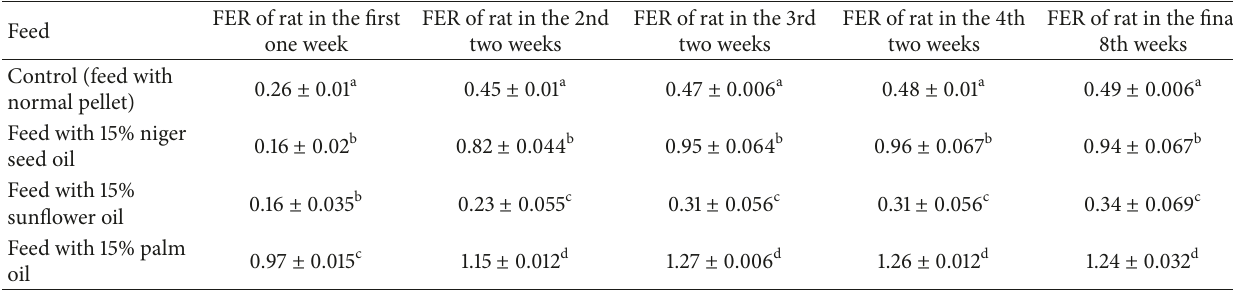
Data were expressed as means ± SD ( 𝑝 < 0.05 ). Values with different letters within the same column are statistically significant. In all comparisons the 𝑝 -value is less than 0.05 except the comparison between 15 % Sunflower oil and 15 % Niger seed oil on FER of Rat in the first one week of the experiment in which the 𝑝 > 0.05 .